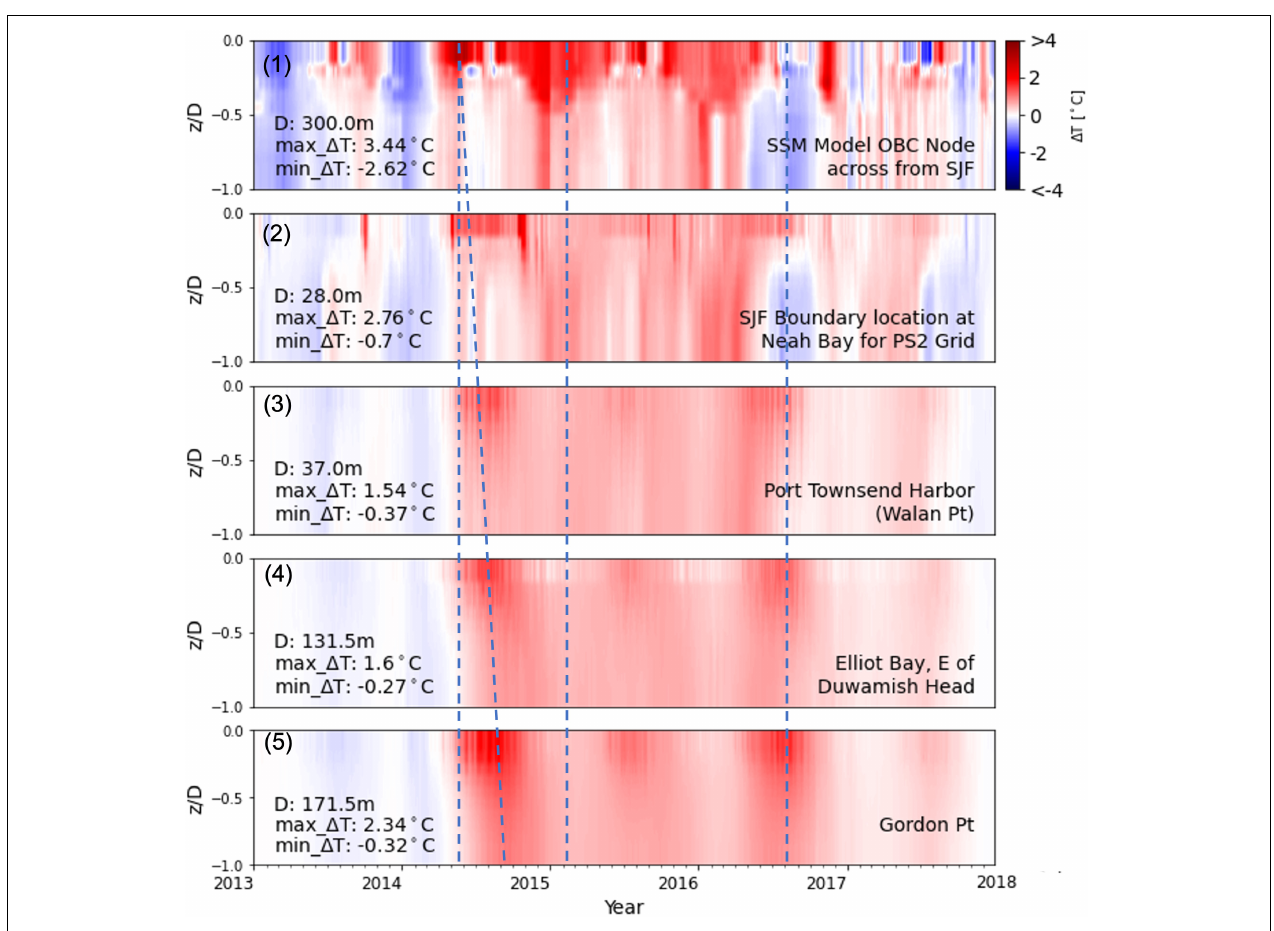
FIGURE 7 | Depth-time profile contour plots of temperature difference ( (cid:49) T) at selected stations relative to reference condition normalized relative to the depth of the water colum (z/D): (1) ocean boundary directly across from Neah Bay at the mouth of Strait of Juan de Fuca, (2) Neah Bay, (3) Port Townsend, (4) Elliot Bay, and (5) Gordon